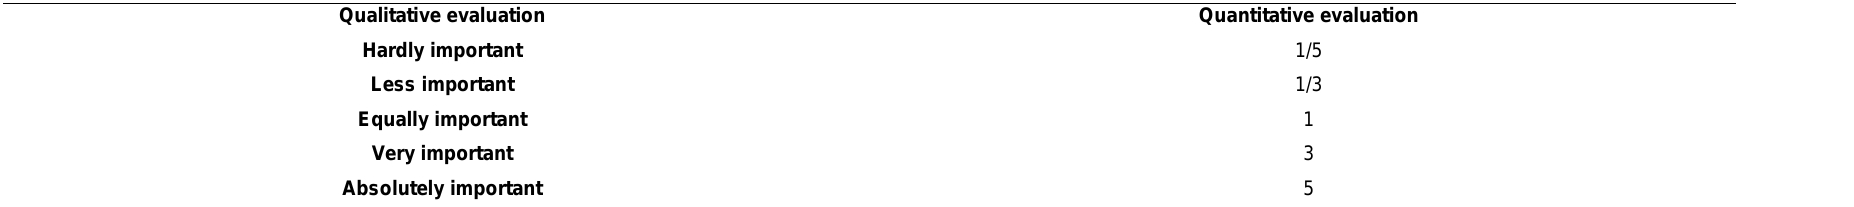
Table 5. Importance evaluation of the evaluation